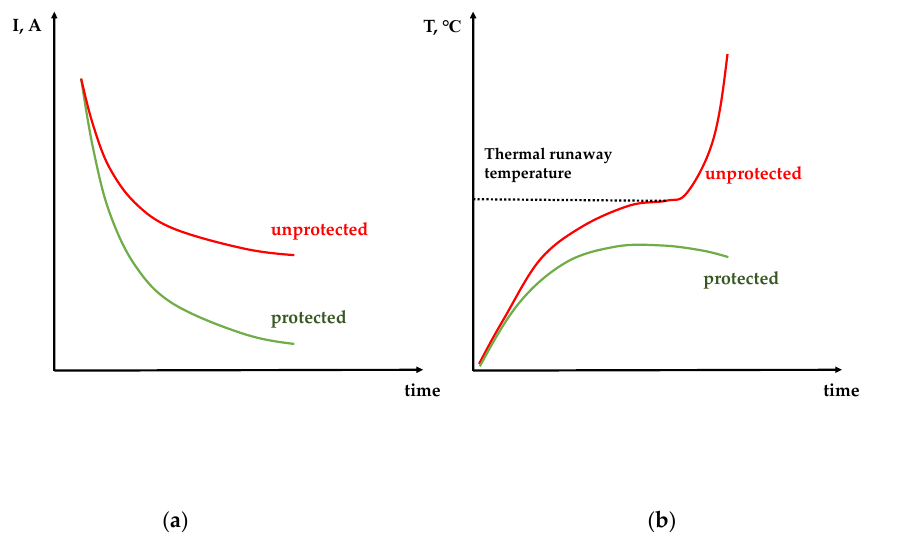
Figure 3. Schematic representation of the current versus time ( a ) and temperature versus time ( b ) behavior of protected (green) and unprotected (red) batteries.